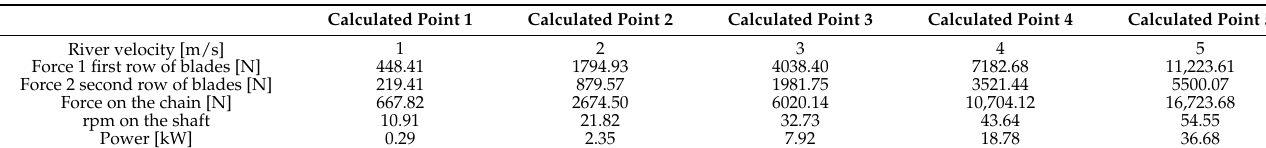
Table 1. Results of numerical calculations of mini-HPP capacity.